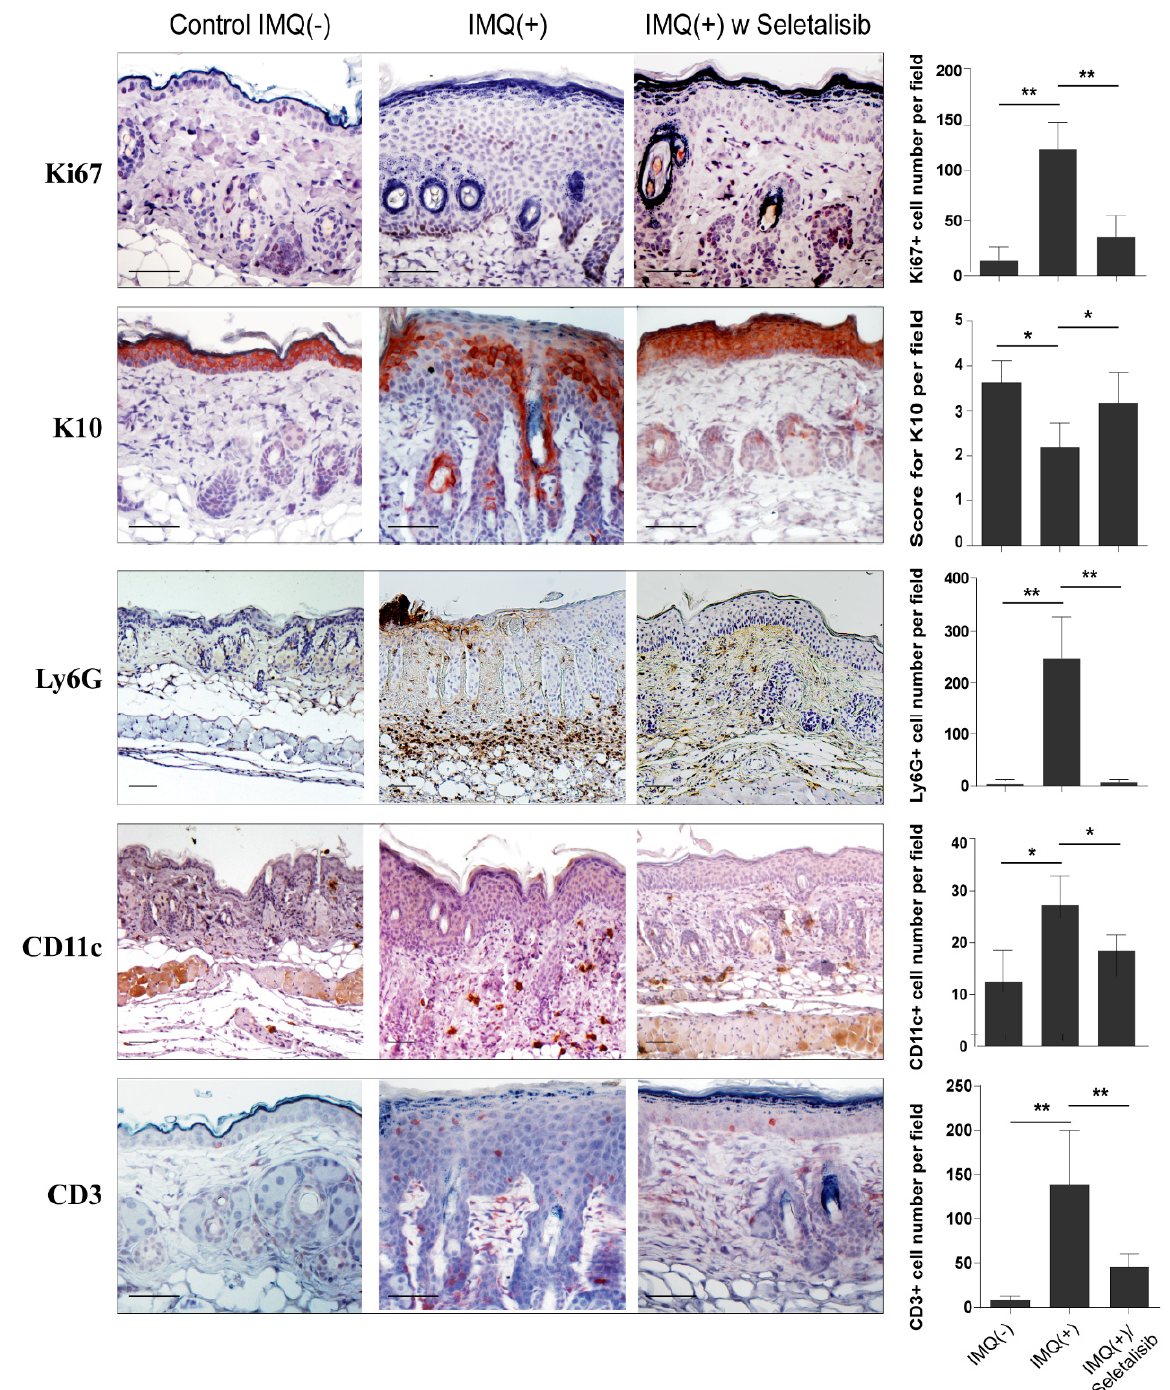
Figure 6. Seletalisib reverts the pathological markers in IMQ-induced murine model of psoriasis. In vivo expression of Ki67, K10, Ly6G, CD11c (all red-brown staining), and CD3 positve cells (red staining) was evaluated by IHC analysis on skin sample sections of control IMQ ( − ) ( n = 2), IMQ (+) ( n = 6), and IMQ (+) w seletalisib ( n = 6) mice groups. Sections were counterstained with Mayer’s H&E and were visually evaluated by a pathologist experienced in dermatology. One out of ten representative stainings is shown. Bars, 200 µ m. Graphs show the mean of number of positive cells for Ki67, Ly6G, CD11c, and CD3 expression analysis, or of four-stage score values for K10 ± SD per three sections per experimental group ( n = 2 mice, Control IMQ ( − ); n = 6 mice, IMQ (+) and IMQ (+)/seletalisib groups). * p ≤ 0.05, ** p ≤ 0.01, as assessed by unpaired Student‘s t test.